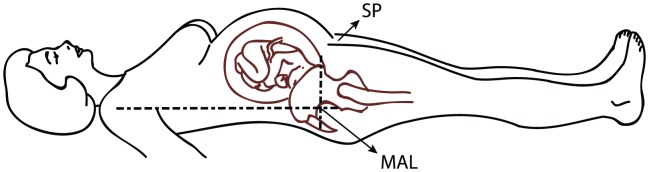
Anatomic orientations of the zero-reference points.SP: Symphysis pubis; MAL: Mid axillary line.